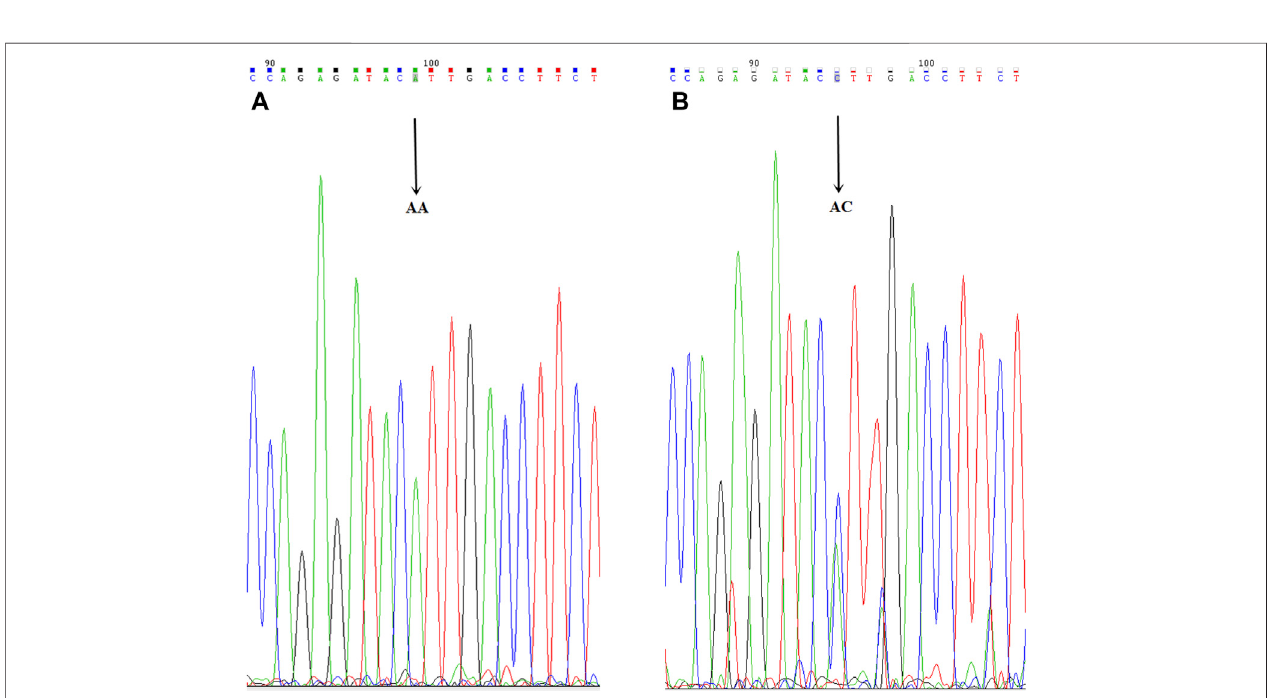
FIGURE 5 | CYP2C9*3 mutant allelic variant map. AB is the mutation sequence, and the arrow is the mutation site (AA/AC), where AC is the mutant gene.